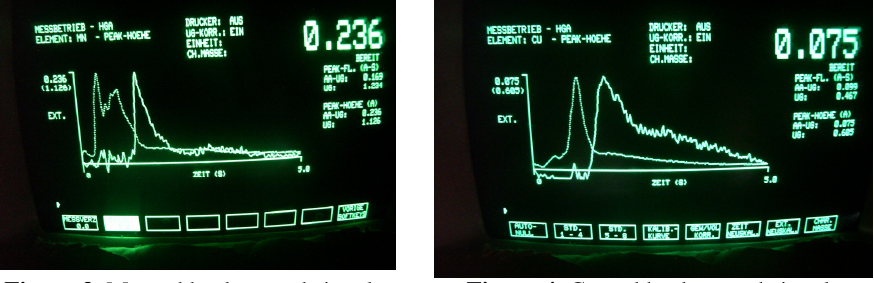
Figure 3 . Mn and background signals Figure 4 . Cu and background